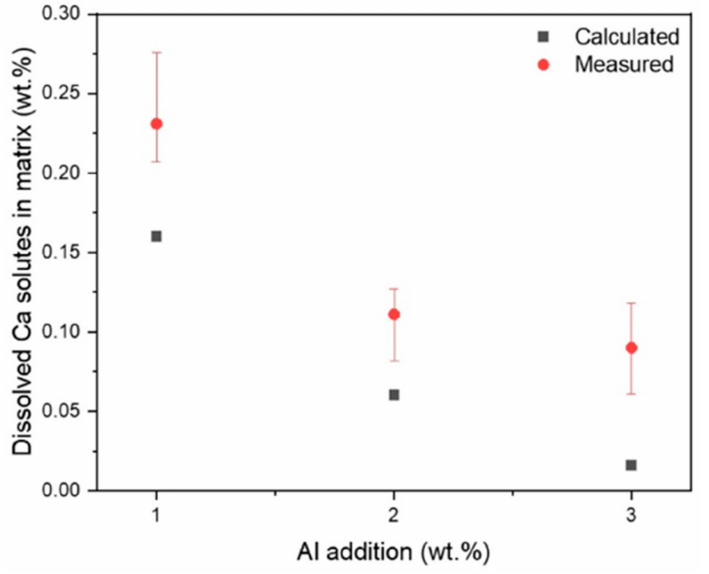
Figure 6. Amount of the dissolved Ca solutes in matrix according to the Al content at 400 ◦ C, compar- ing the experimentally measured values by SEM-EDS and the calculated amounts by Pandat